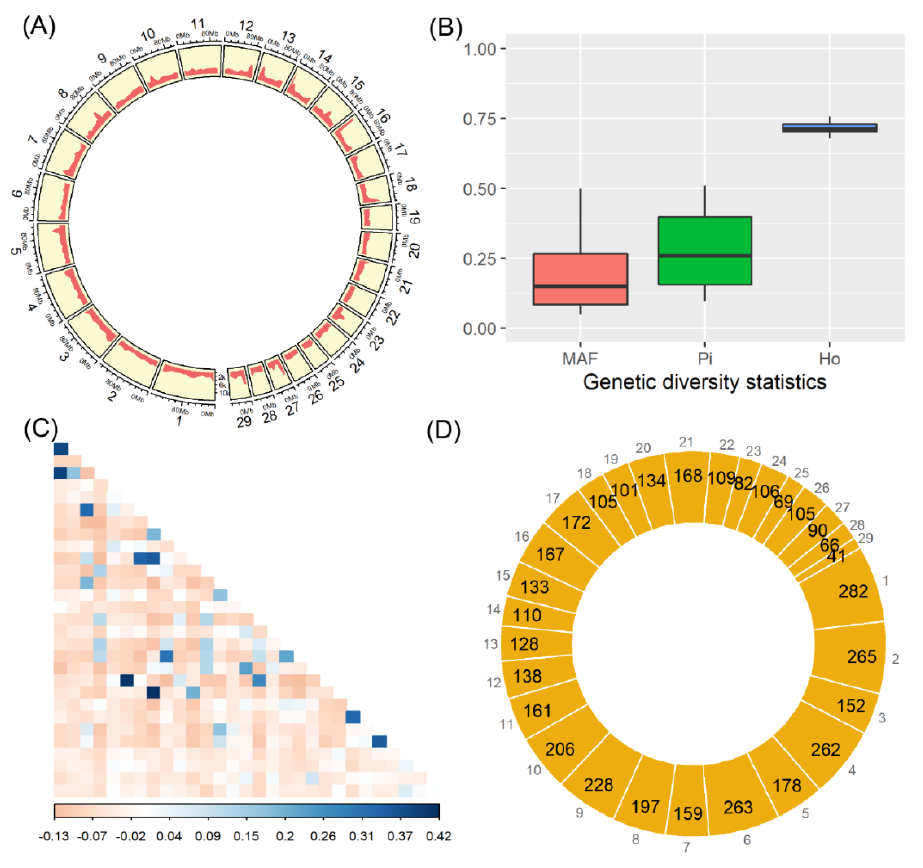
Figure 1. Results of SNPs, genetic diversity, and runs of homozygosity. All SNPs were illustrated for their genomic distribution, with the number of SNPs (y-axis) per 10 Mb genomic region ( A ), the calculated statistics of minor allele frequency (MAF), nucleotide diversity (Pi), and the observed heterozygosity (Ho) in ( B ), and the derived pairwise relatedness among individuals ( C ). Among the 29 autosomes, the numbers of runs of homozygosity are schematically shown in ( D